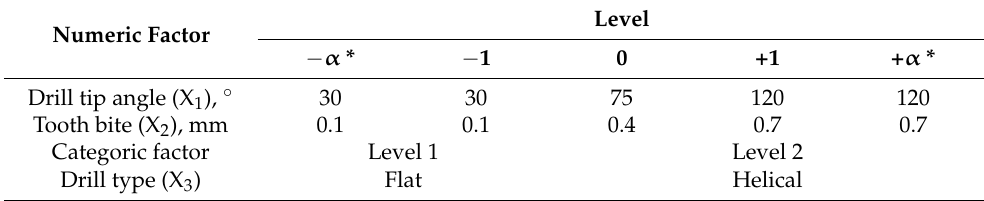
Table 2. The values of analyzed input factors.